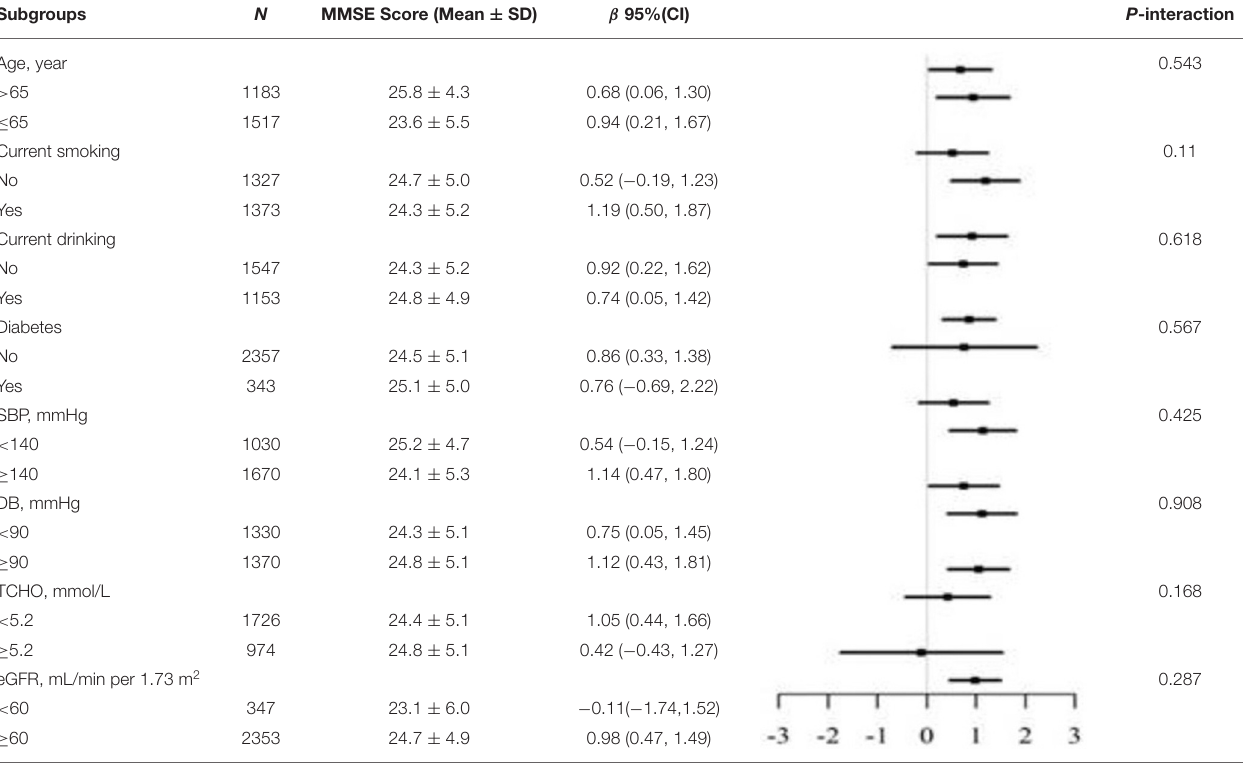
TABLE 3 | Stratified analyses of association between LAP as a common logarithm-transformed continuous variable and cognitive function represented by MMSE scores in male.